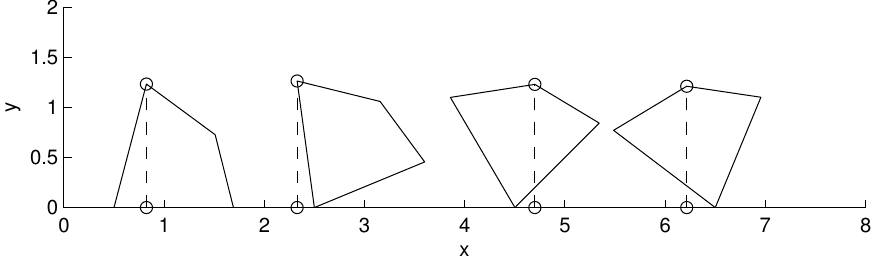
Figure 2. Procedure to search the optimal direction of coverage. The area is rotated until the smallest height is found.